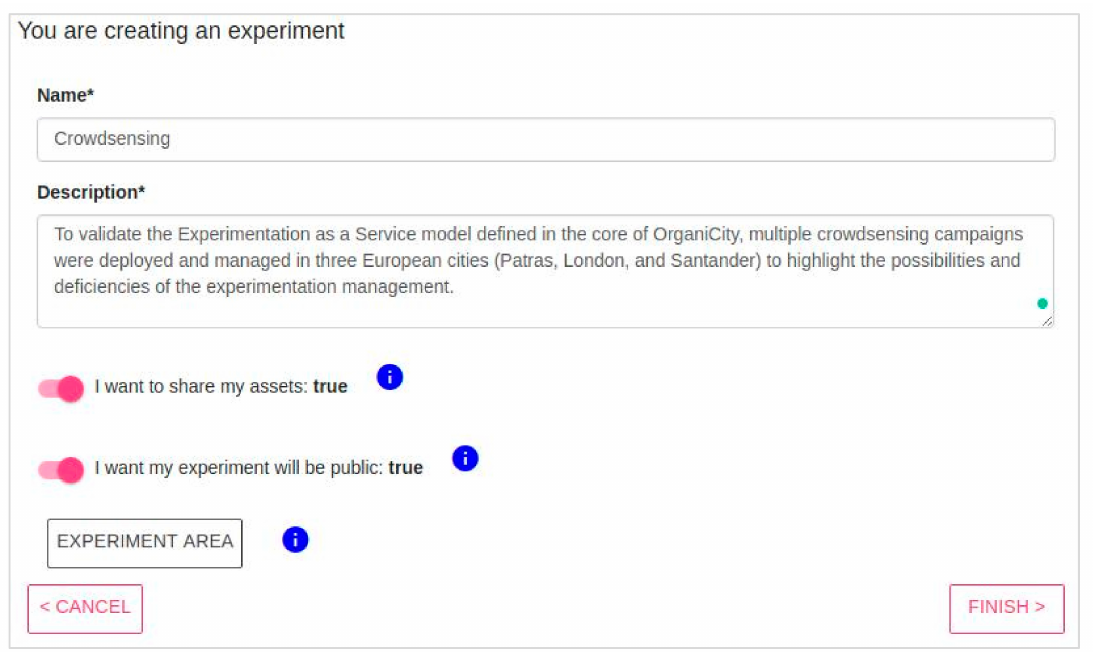
Figure 2. Screenshot of the Experimenter Portal to provide general experiment